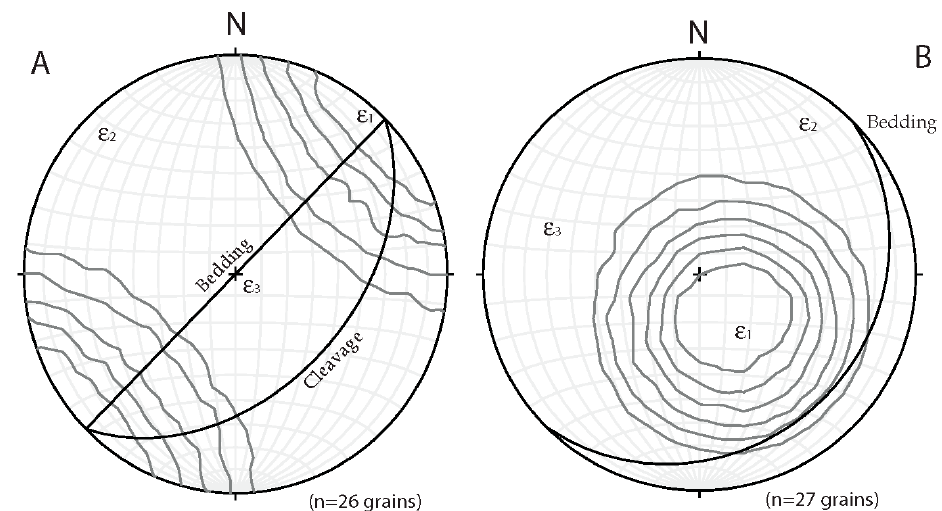
Figure 5. Lower hemisphere stereoplots of “contrived” strain overprint data (NEVs) for ( A ) the calcite veins in the calcareous siltstone and ( B ) the bedding-parallel normal fault. Strain axes (E1 = shortening, E2 = intermediate axis, E3 = extension) are plotted with Turner [40] compression axes contoured. See Table 2.